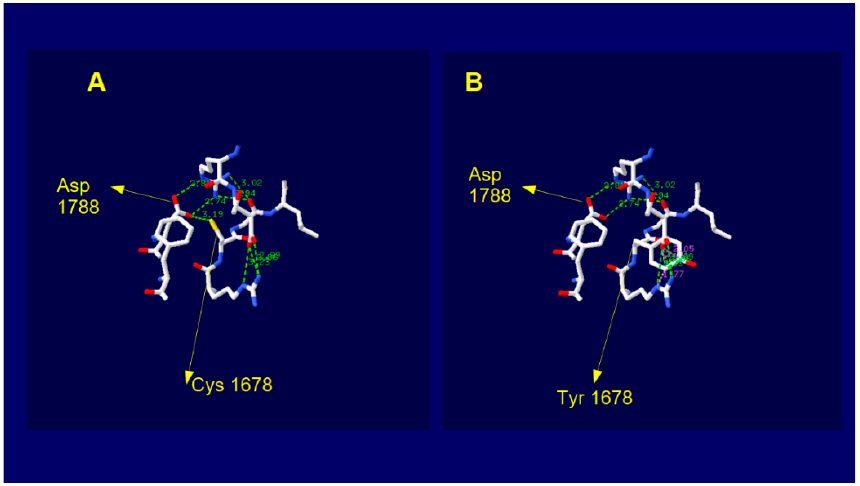
Figure 5. 3D structure images of the AlphaFold dysferlin model showing the atomic interactions centered on the residue 1678 and in a range of 8Angstrom. ( A ) wild type model with cysteine residue 1678 forming a H-bond with Aspartic at position 1788; ( B ) model upon Cysteine > Tyrosine change. Green dashed lines and green numbers indicate the H-bond and the respective interatomic distances, respectively. Residues 1678 and 1788 are indicated.